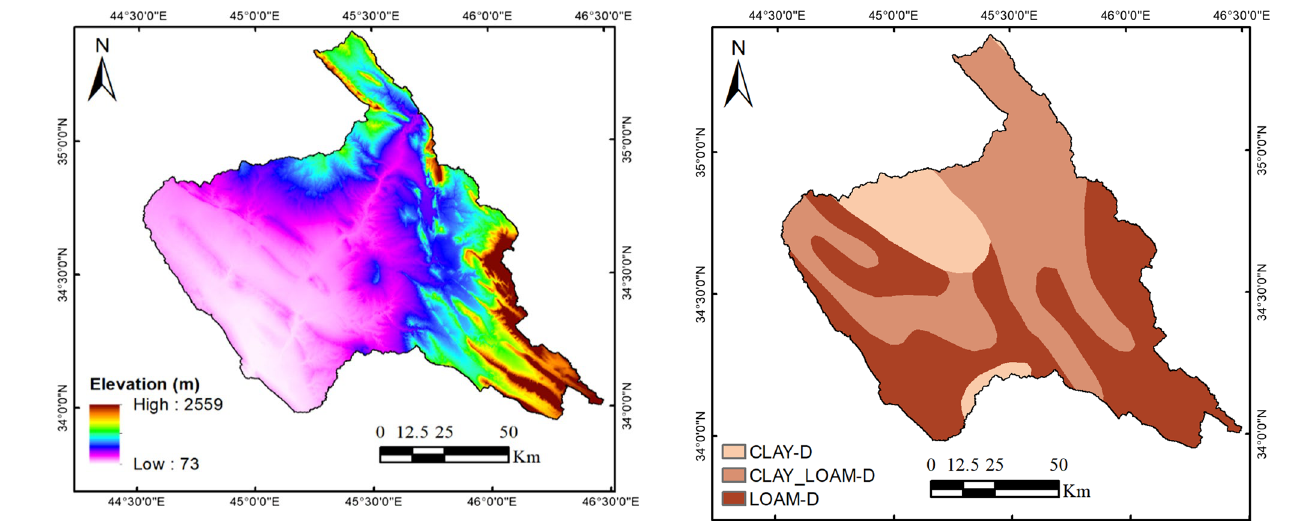
Fig. 5 Soil type and hydrological group of Hemren dam reservoir